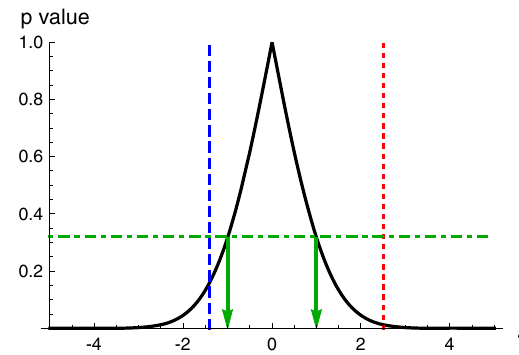
Fig. 2 On the left for a given observation X = 0 ± 1, p value p ( 0 ; μ) as a function of the value of μ being tested. Blue dashed and red dot- ted lines correspond to μ = − 1 . 4 and μ = 2 . 5. A confidence interval for μ at 68% CL is obtained by considering the region of μ with a p